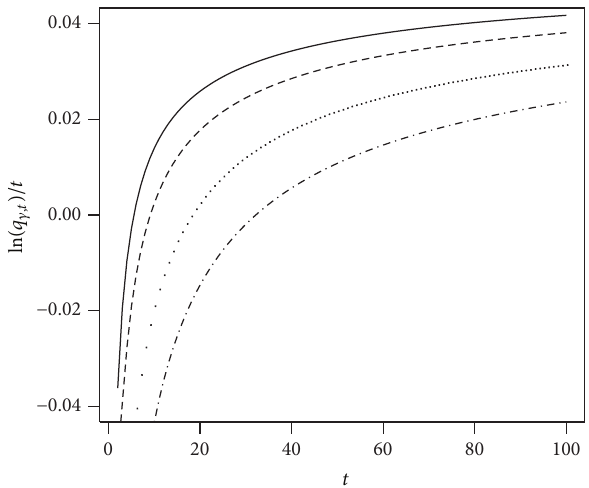
Figure 1: The plot shows ln (𝑞 𝛾,𝑡 )/𝑡 as a function of 𝑡 in our example. Parameters are 𝑟 = 4 %, 𝜇 = 8 %, 𝜎 = 20 %, ] = 0 %, and 𝛼 = 50 %. We set 𝛾 = 10 % (solid), 5 % (dashed), 1 % (dotted), and 0.1 % (mixed).